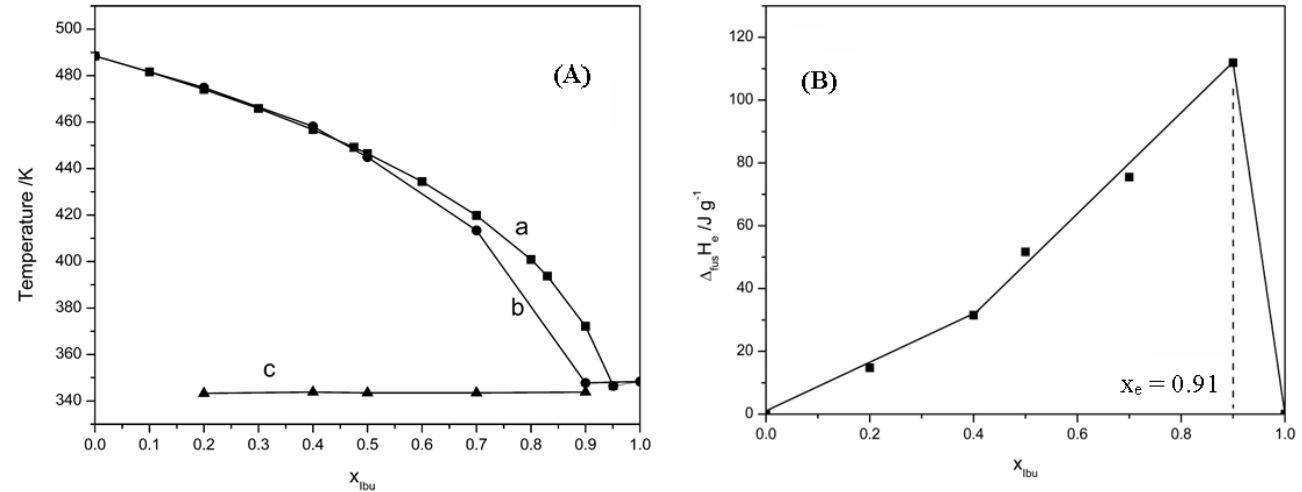
Figure 4. ( A ). Phase diagram of binary mixture Ibu—D-HCl: a. ideal behavior; b. real behavior; c. eutectic temperature. ( B ). Tammann’s plot .